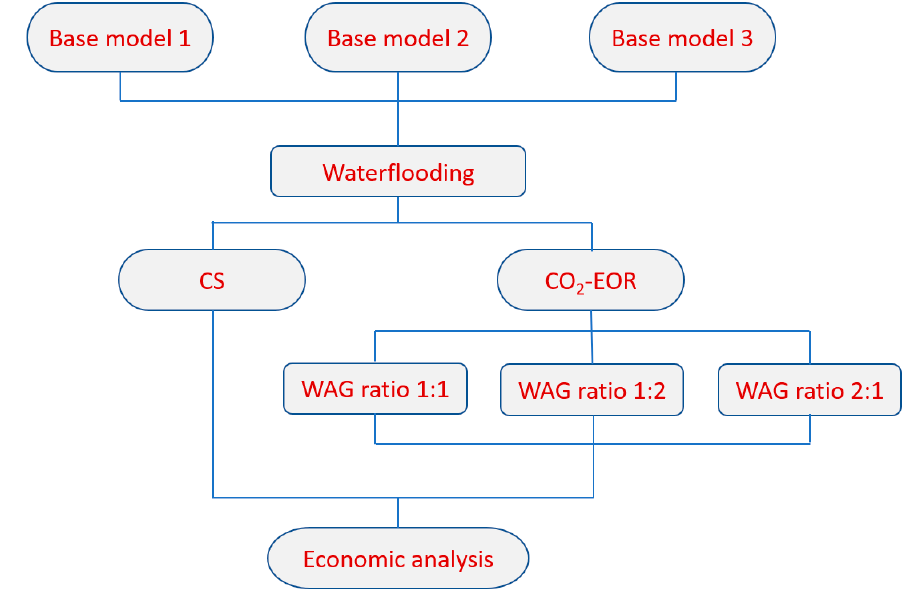
Figure 2. Model development